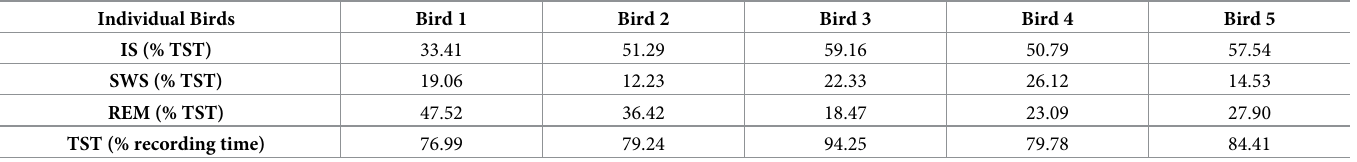
For each individual bird, the 3 main sleep states are shown as a percentage of TST for the nighttime. TST is shown as a percentage of the total recording time over the